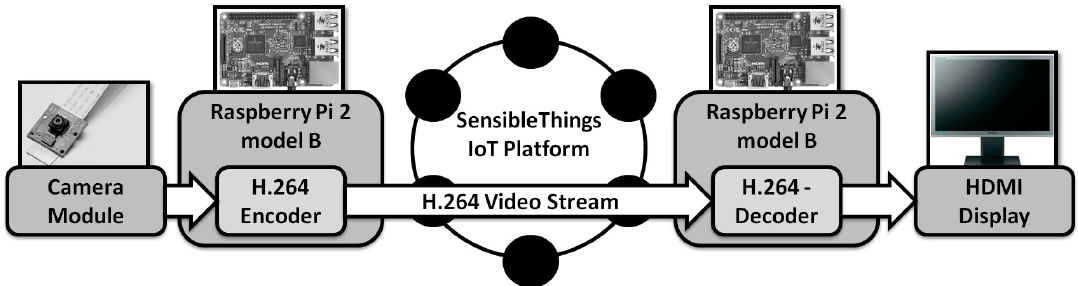
Figure 1. An overview of the